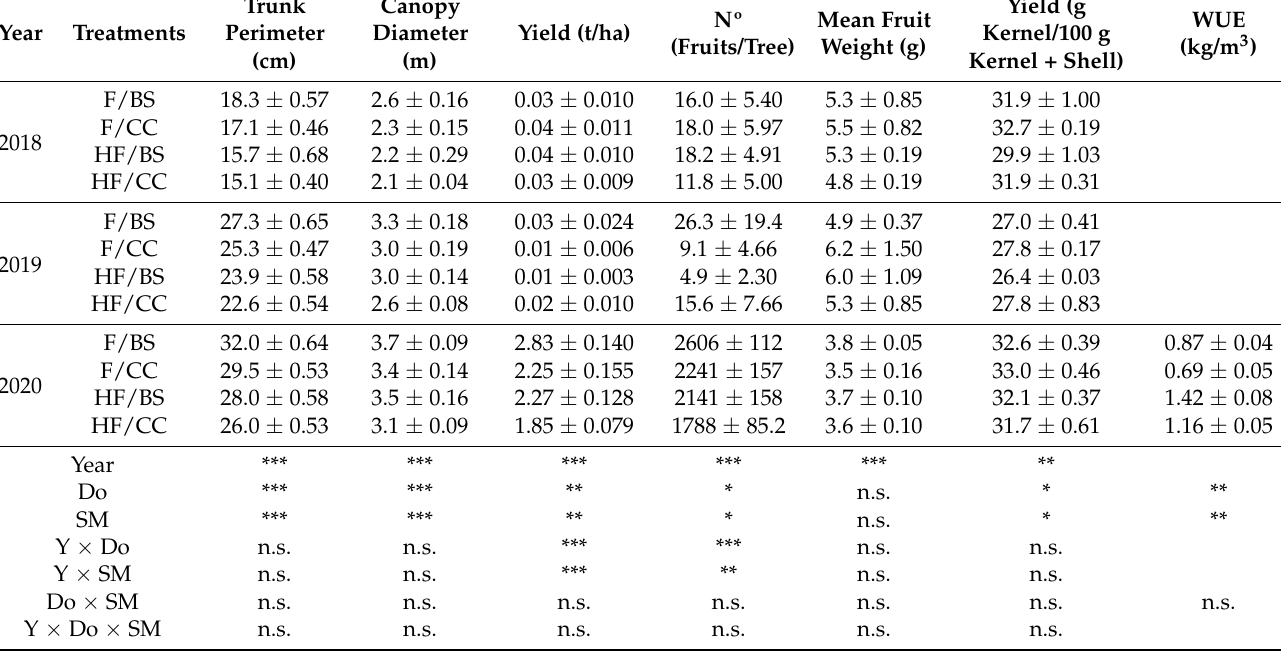
Table 1. Effects of the fertigation dose (Do) (farmer (F) and half farmer (HF)), soil management (SM)(bare soil (BS) and cover crops (CC)), year (Y) and its interactions on vegetative growth and yield components. Water use efficiency (WUE) is shown for the year 2020. Data shows the mean ± standard error.